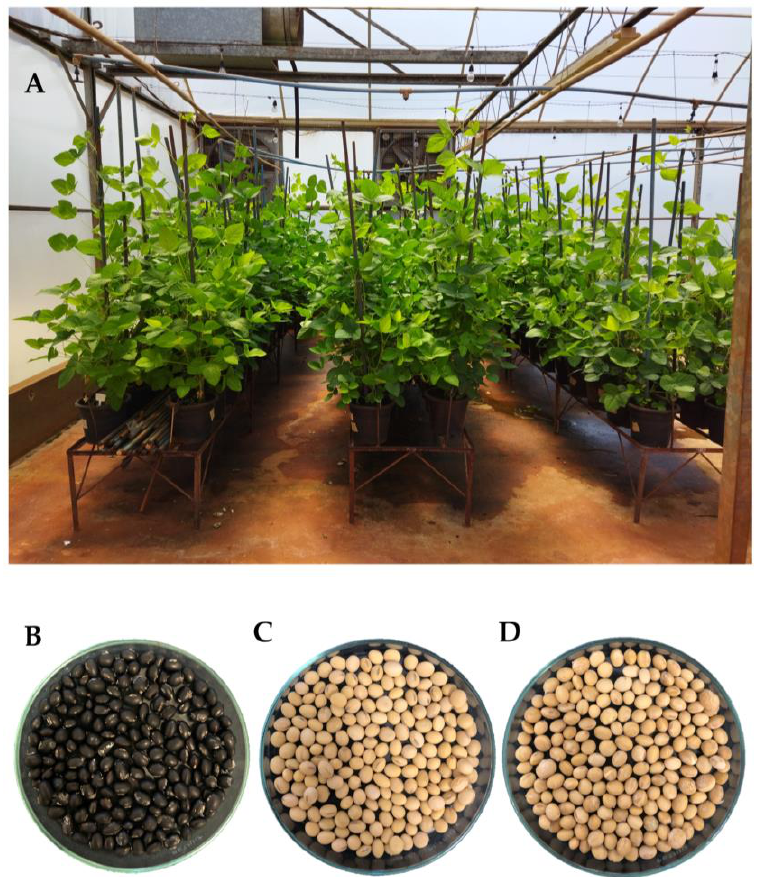
Figure 1. Experiment conducted in greenhouse to collect material for RNA extraction ( A ). Seeds of the BRSMG 715A genotype ( B ). Seeds of the BRS 413 RR genotype ( C ). Seeds of the DM 6563 IPRO genotype ( D ).